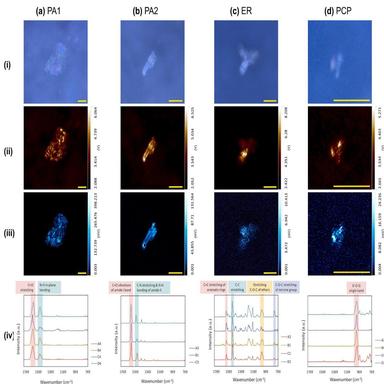
The identification of resin additives and polysiloxane-containing microplastics originated from the IV delivery system. The resin additives and polysiloxanecontaining MP-types discharged from various parts of the IV system are organized in a columnar format, including (a) PA type 1, (b) PA type 2, (c) ER, and (d) PCP. The rows of the illustration display several data types, namely (i) Optical Images, (ii) Visible-Laser Images, (iii) O-PTIR images that capture representative MPs on Anodisc filter membranes,